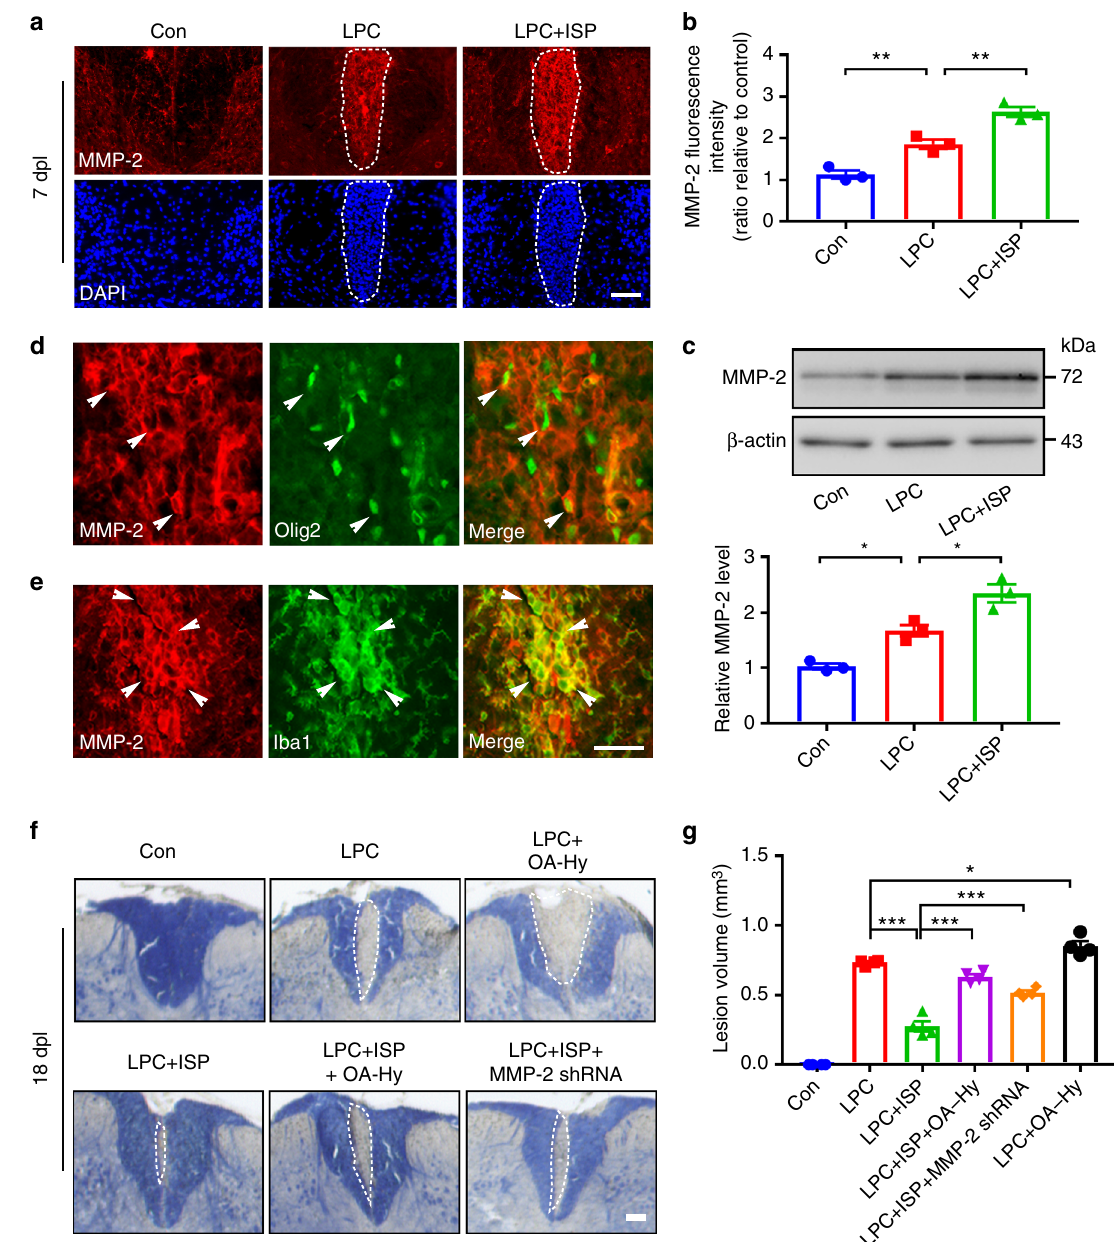
Fig. 8 ISP promotes myelin repair through increasing MMP-2 expression in LPC-induced demyelination model. a Representative images from immunohistochemistry of MMP-2 and DAPI show increased levels of MMP-2 in the spinal cord of ISP-treated mice at 7 days post-LPC injection (dpl) compared to naive or LPC vehicle control cords. Dashed lines demarcate lesion areas. Scare bar = 100 μ m. b Relative quanti fi cation of immuno fl uorescence intensity of MMP-2 in the spinal cord of ISP-treated mice at 7 dpl ( n = 3 mice/group, ANOVA F(2,6) = 48.12, Tukey ’ s multiple comparison test, P con versus = 0.0075, P = 0.0056). c Western blot analysis of MMP-2 expression in spinal cord tissue of naive, vehicle, or ISP-treated mice at 7 LPC LPC versus LPC + ISP dpl. Data normalized to β -actin protein expression ( n = 3 mice/group, ANOVA F(2,6) = 33.14; Tukey ’ s multiple comparison test, P con versus LPC = 0.0168, P = 0.0143). d Representative immunohistochemistry images show Olig2 + OPCs expressing MMP-2 in the spinal cord of ISP-treated mice LPC versus LPC + ISP at 14 dpl. White arrows indicate the colocalization of MMP-2 and Olig2. e Representative immunohistochemistry images show Iba1 + cells (microglia/ macrophage) expressing MMP-2 in the spinal cord of ISP-treated mice at 14 dpl. White arrows indicate the colocalization of MMP-2 and Iba1. Scare bar = 100 μ m. f Representative eriochrome cyanine (myelin) staining of LPC lesions from the spinal cords of naive, vehicle, ISP, MMP-2 inhibitor (OA-Hy), or MMP-2 shRNA-treated mice. Dashed lines demarcate lesion areas. Scale bar = 100 μ m. g Quantitative analysis of the volume of lesioned spinal cord in vehicle, ISP, MMP-2 inhibitor (OA-Hy), or MMP-2 shRNA-treated mice at 18 dpl ( n = 4 mice/group, ANOVA F(5,18) = 169.7; Tukey ’ s multiple comparison test, P LPC versus LPC + ISP < 0.0001; P LPC + ISP versus LPC + ISP + OA-Hy < 0.0001; P LPC + ISP versus LPC + ISP + MMP-2 shRNA < 0.0001; P LPC versus LPC + OA-Hy = 0.0279). The data are presented as mean ± s.e.m. * P < 0.05, *** p <